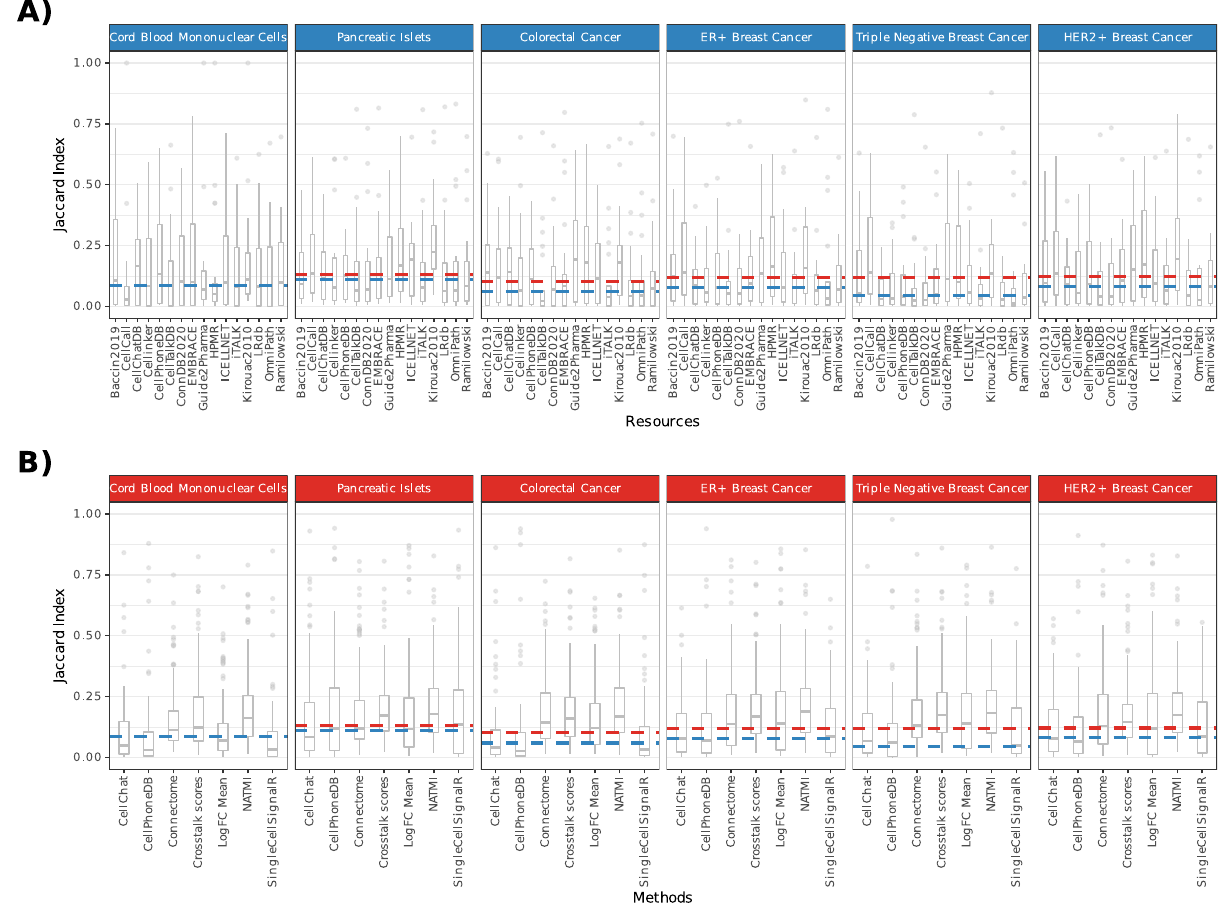
Fig. 5 Overlap of predictions using any combination of CCC methods and resources. Overlap (Jaccard index) in the 1000 highest ranked ( A ) when using the same Resource with different Methods (Blue; n = 7) and ( B ) when using the same Method with different Resources (Red; n = 16). Boxplots represent the median pairwise jaccard index with hinges showing the fi rst and third quartiles and whiskers extending 1.5 above and below the interquartile range. The dashed lines represent the median when using different resources (red) and methods (blue); the lines overlap for the CMBCs dataset. Source data are provided as a Source Data fi